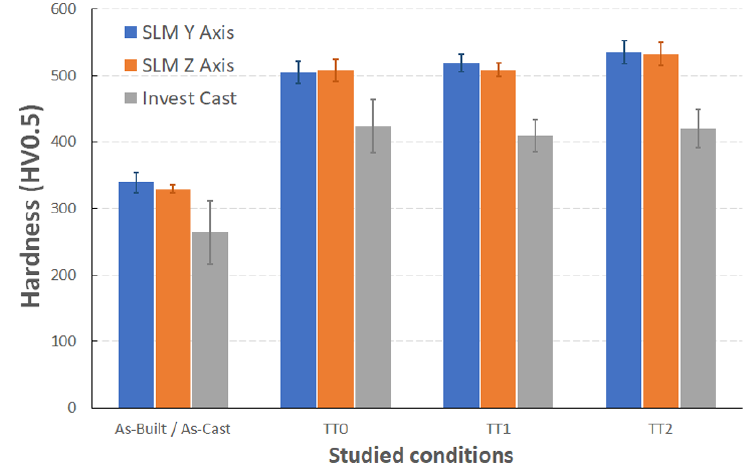
Figure 19. Hardness evolution for SLM and investment casting samples in different conditions. Figure 19. Engineering stress–strain curves for investment casting samples in different conditions.